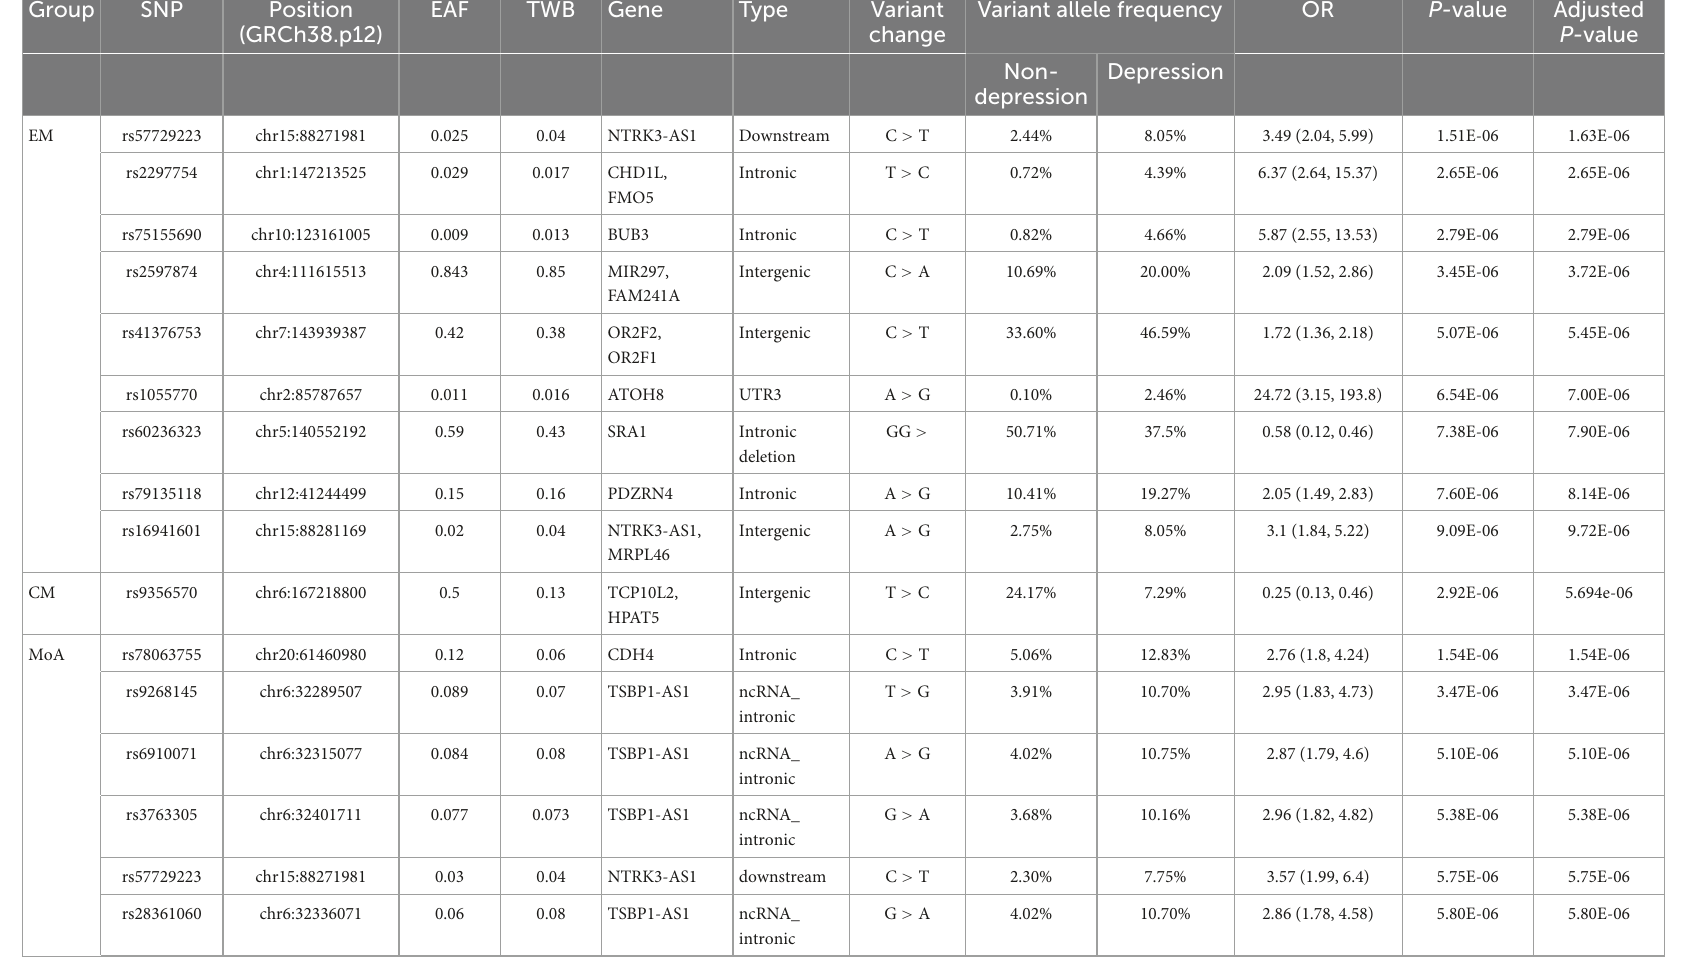
TABLE 3 Association among episodic migraine (EM), chronic migraine (CM), migraine with aura (MA), and migraine without aura (MoA) with depression.